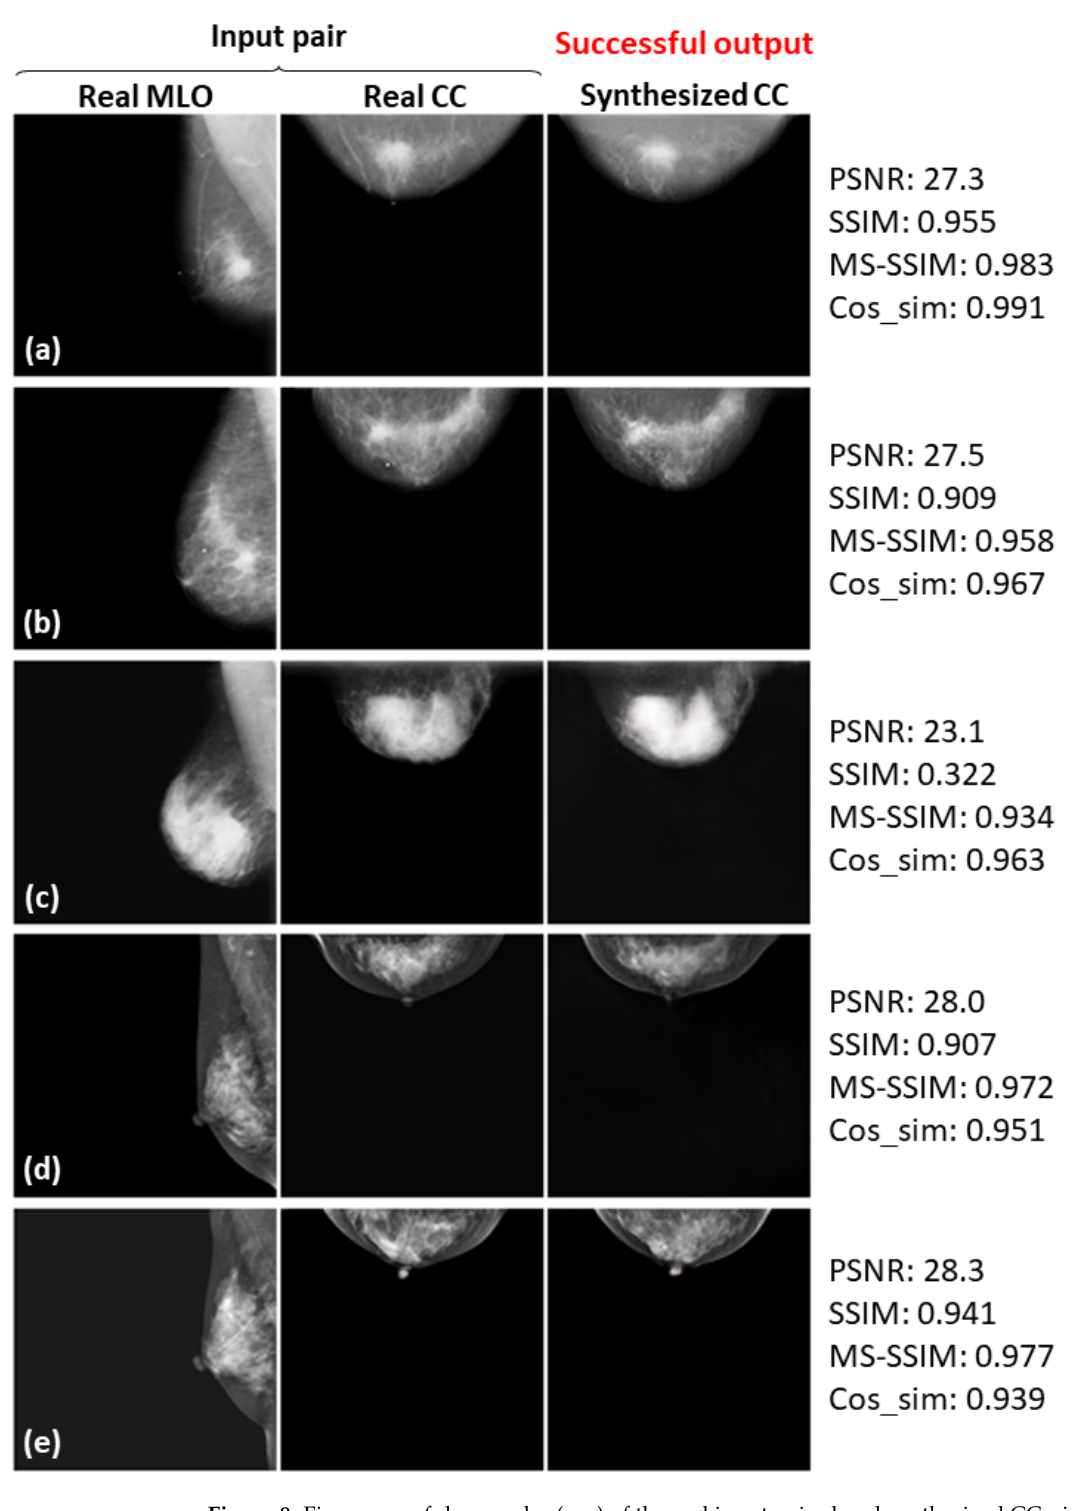
Figure 8. Five successful examples ( a – e ) of the real input paired and synthesized CC-view mammo- grams at 128 × 128 resolution by bi-directional training of CR-GAN incorporating PG technique and feature matching